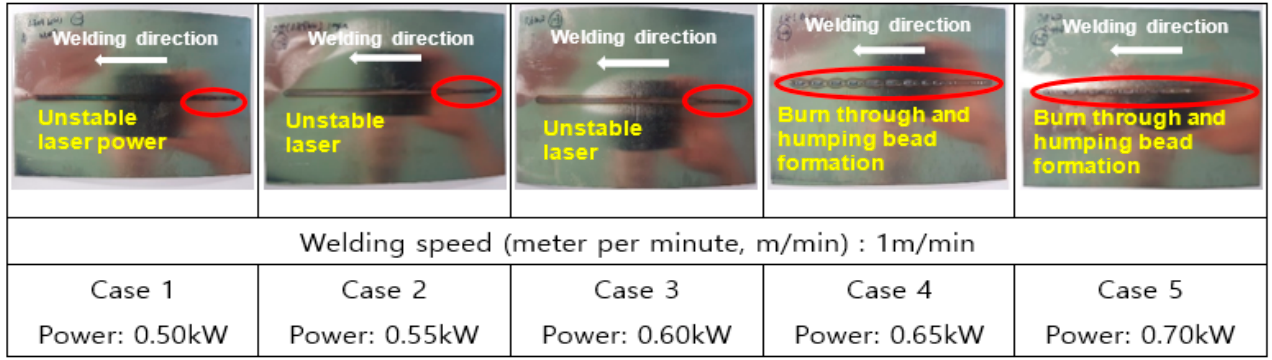
Figure 8. Surface geometry of the first experiment of Lap joint welding.